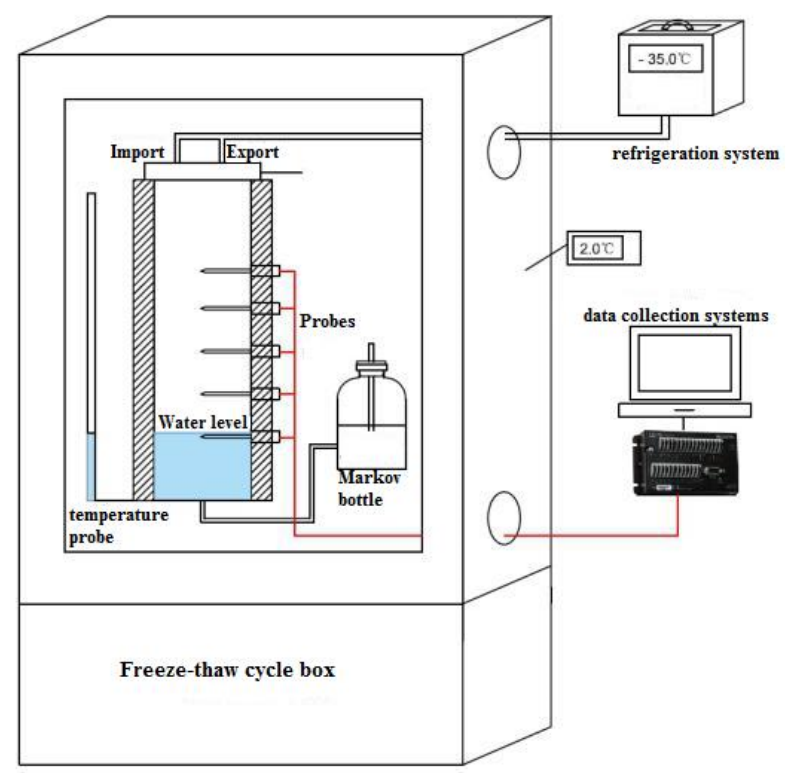
Figure 1. Schematic diagram of the experimental setup.